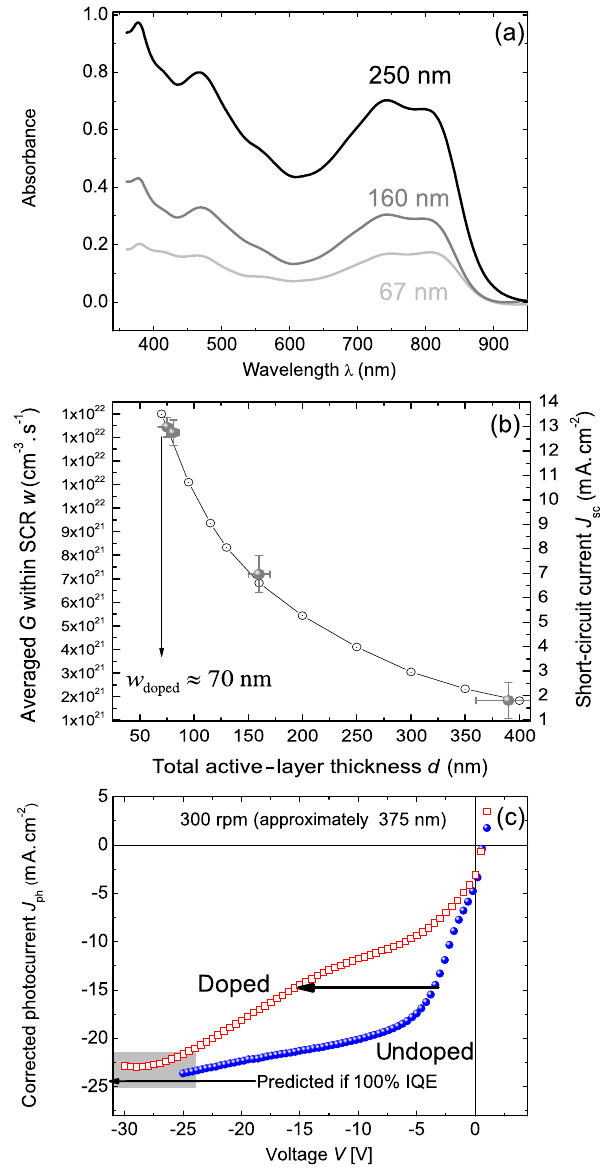
FIG. 4. (a) UV-vis spectra showing the absorbance between 350 and 950 nm of a thickness series of DPP-TT-T − PC 71 BM devices in conventional architecture with a high doping level ( N A ≈ 1 × 10 17 cm − 3 , from a previous batch). (b) Averaged gen- eration rate G x calculated by the matrix-modeling technique within the space-charge region w (open circles) at different active- doped layer total thicknesses for the doped ( N A ≈ 7 – 8 × 10 16 cm − 3 ) batch. The measured short-circuit current J (solid circles) for SC doped devices at the same thickness is shown. The Y error bar corresponds to the standard deviation measured on at least four pixels and x error bars to the uncertainty on the measurements of ¼ the thickness of the active layer. (c) Corrected photocurrent J ph J − J for two DPP-TT-T − PC 71 BM devices of approx- light dark imately the same thickness (approximately 375 nm) at two different doping levels (open square N A ¼ 7 × 10 16 cm − 3 and solid sphere N A ¼ 1 × 10 16 cm − 3